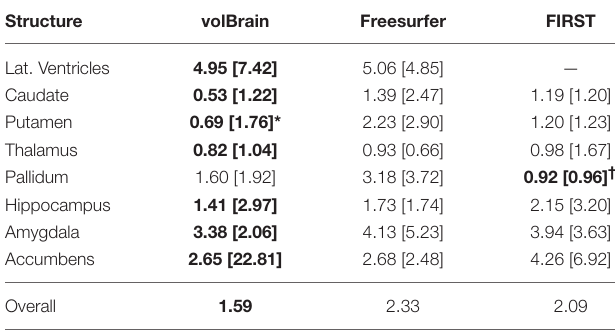
TABLE 2 | Median of PVD.